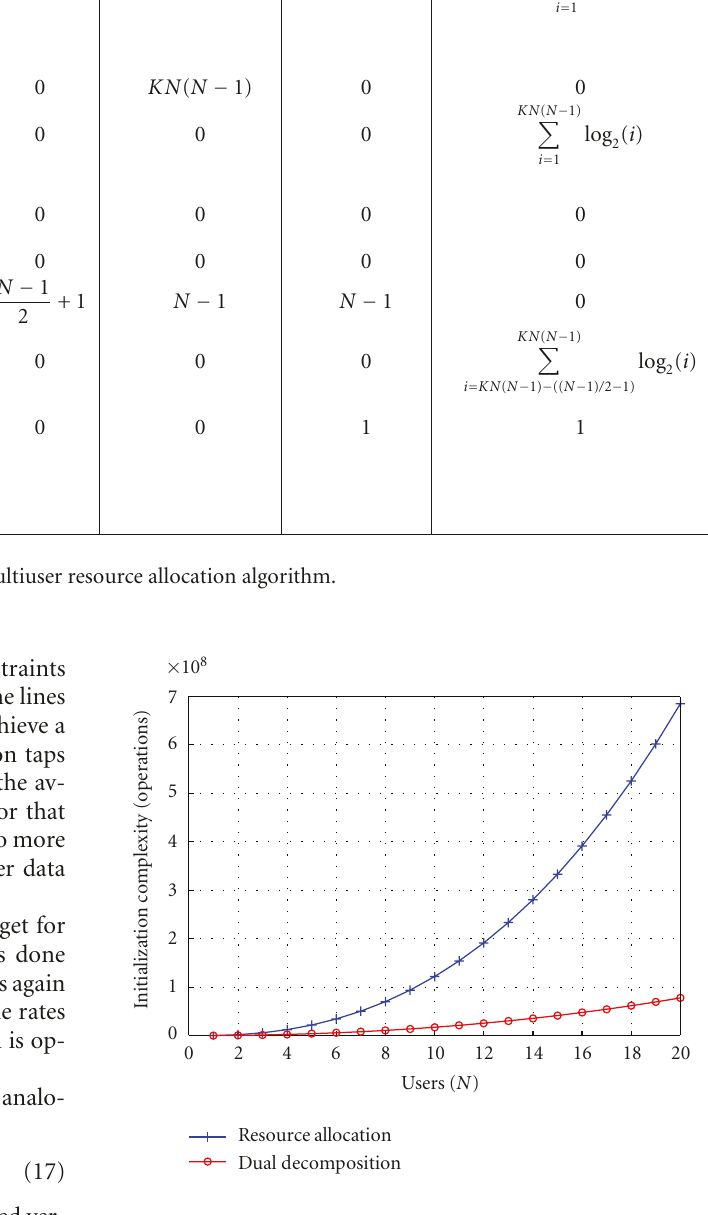
Figure 2: Complexity comparison multiuser